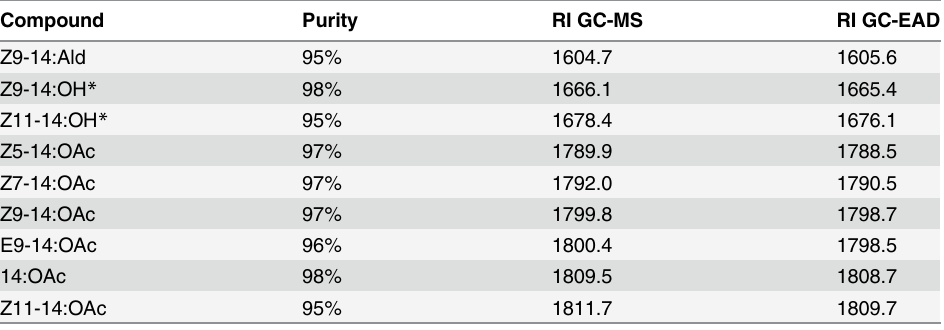
Table 3. Kovats retention index comparison of standard compounds between the GC-MS and GC- EAD (HP5, 0.32 mm, 0.25 μ